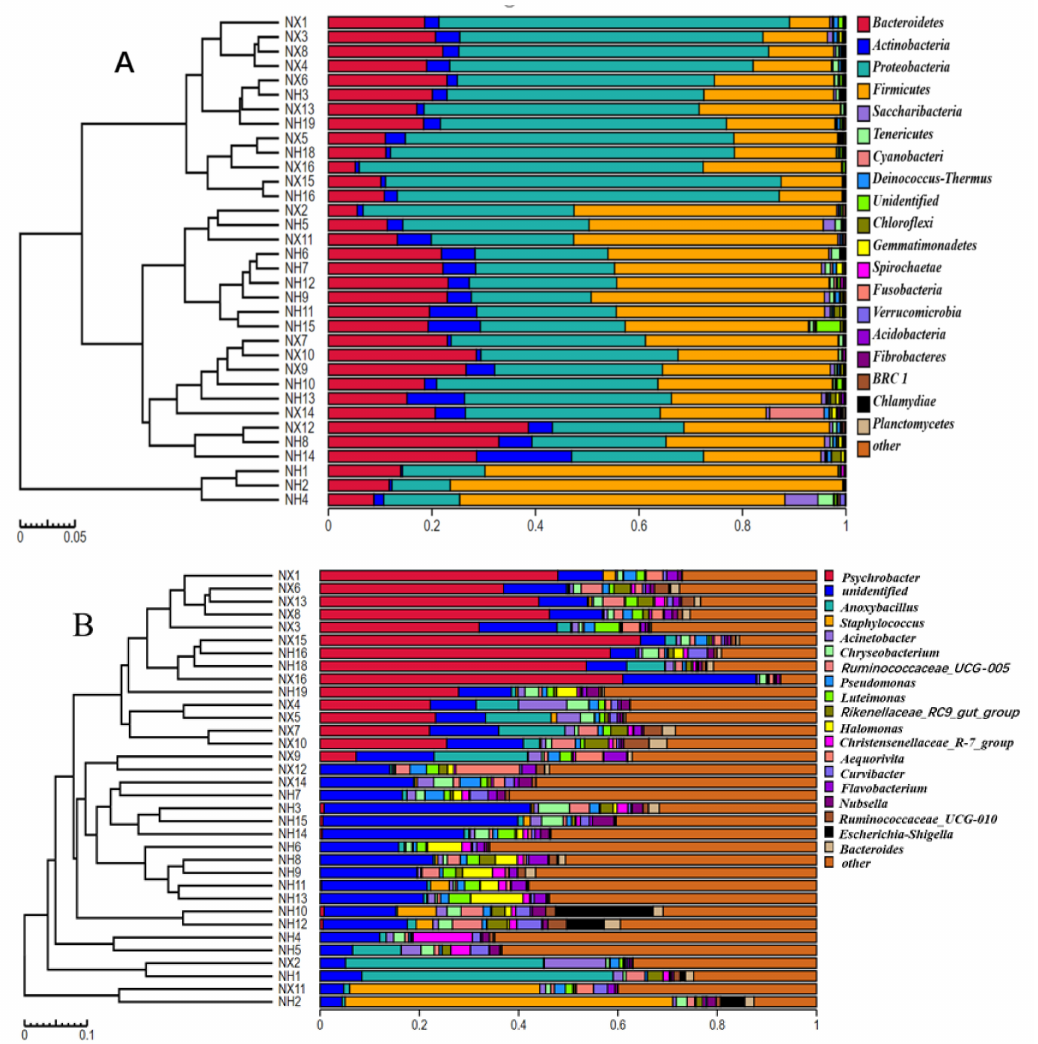
Figure 4. Dendrogram of bacterial composition analysis of colostrum from the X and H dairy farms. ( A ) Dendrogram of bacterial composition analysis of colostrum from the X and H dairy farms at the phyla level; ( B ) Dendrogram of bacterial composition analysis of colostrum from the X and H dairy farms at genus level. Note: NX ( n = 16) and NH ( n = 18) represent the colostrum samples from dairy farm X and dairy farm